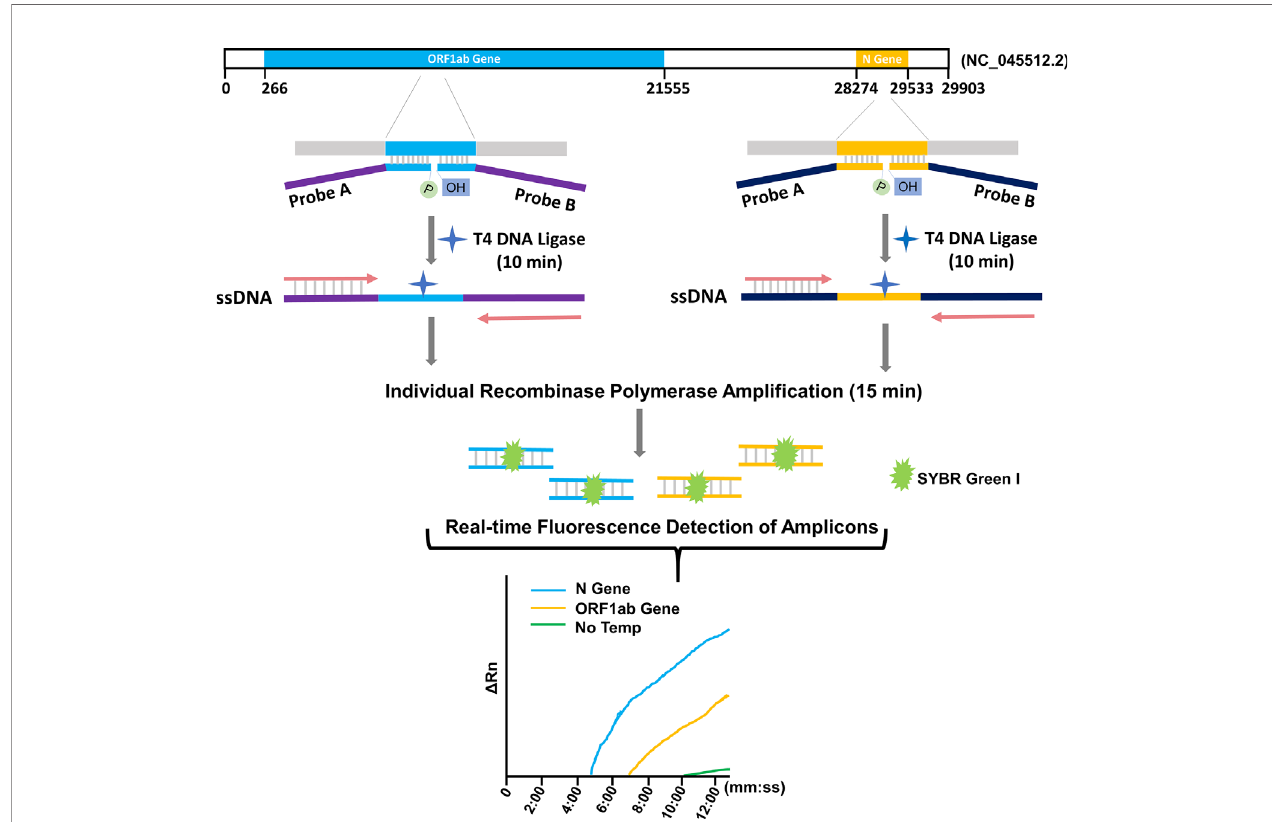
FIGURE 1 | Schematic representation of the L/RPA assay. For each target gene of SRAS-CoV-2 (ORF1ab gene or N gene), an RNA fragment was selected as the detection biomarker. A probe pair (Probe A and Probe B) was designed with the “ annealing portions ” exactly complementary to the targeted biomarker sequence (indicated with color blue or yellow) and the “ ampli fi cation arms ” completely arti fi cial (indicated with color purple or dark blue). With the presence of the viral RNA, the probe set would anneal to the targeted biomarker and be ligated into one ssDNA fragment with the T4 DNA ligase. The ligation product for each biomarker was individually ampli fi ed by RPA with the forward and reverse primers matching the “ ampli fi cation arm ” sequences. With the fl uorescence dye SYBR Green I, the ampli fi cation signals were detected in real-time. No Temp: the control with no viral RNA